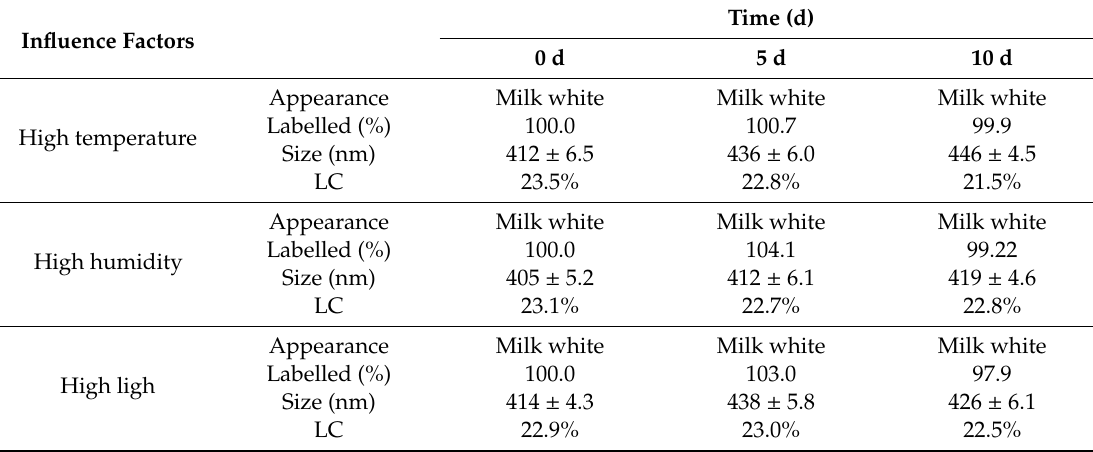
Table 3. The influence factors test of TIL-nanogel (Mean ± SD, n =